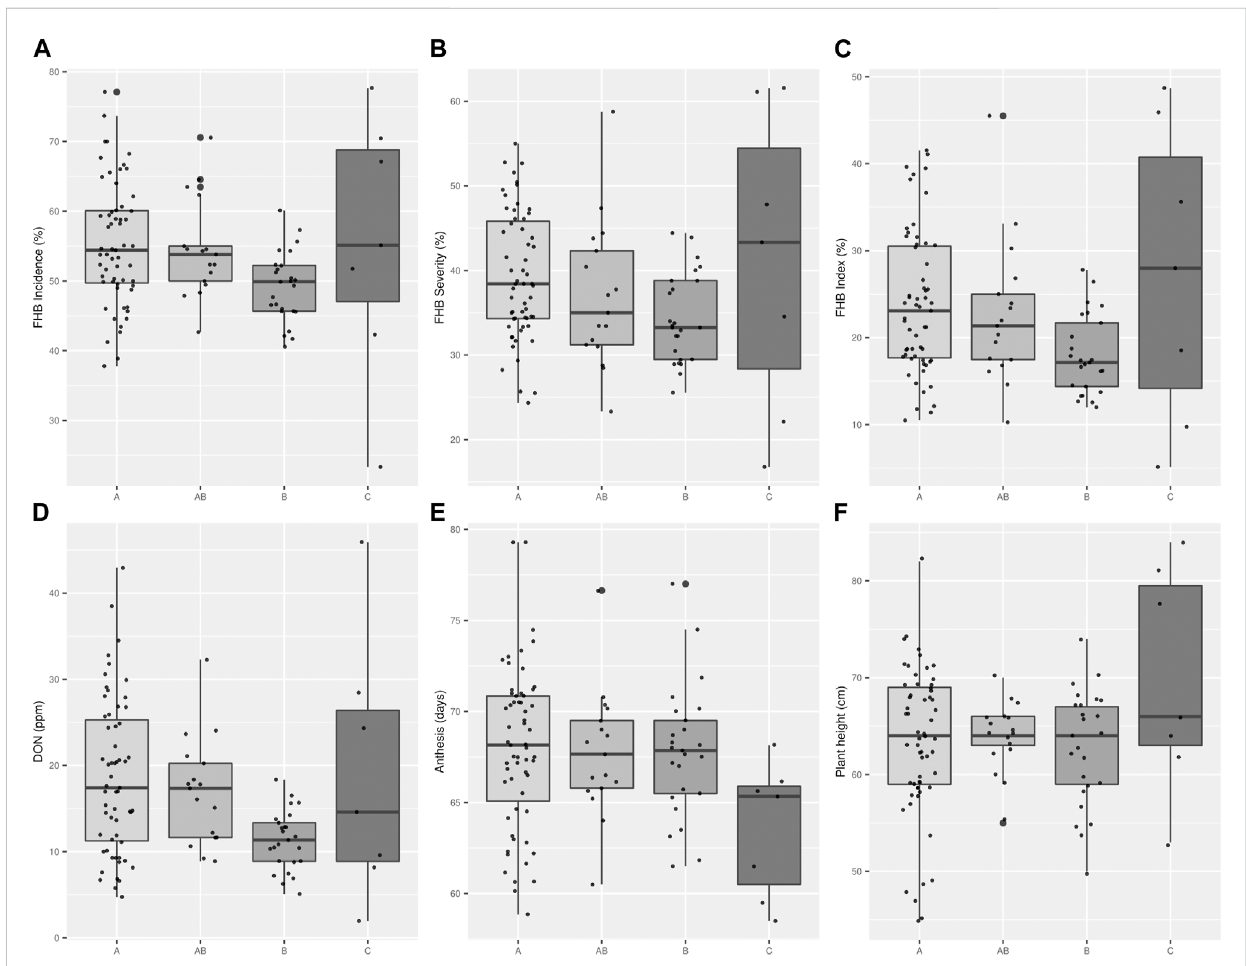
FIGURE 4 Boxplot charts representing the distribution frequency of the analysed Brazilian cultivars and Canadian checks in traits related with Fusarium head blight (FHB): incidence (A) , severity (B) , index (C) , Deoxynivalenol (DON (D) ), anthesis (E) and plant height (F) . The Brazilian cultivars were divided by collections: “ A ” present in the older collection, “ B ” present in the newer collection, “ AB ” in both collections. “ C ” refers to Canadian checks. The data is derived from the evaluation of Brazilian cultivars grew at Ottawa 2021 and at Morden 2017 and 2018 under arti fi cial inoculation and